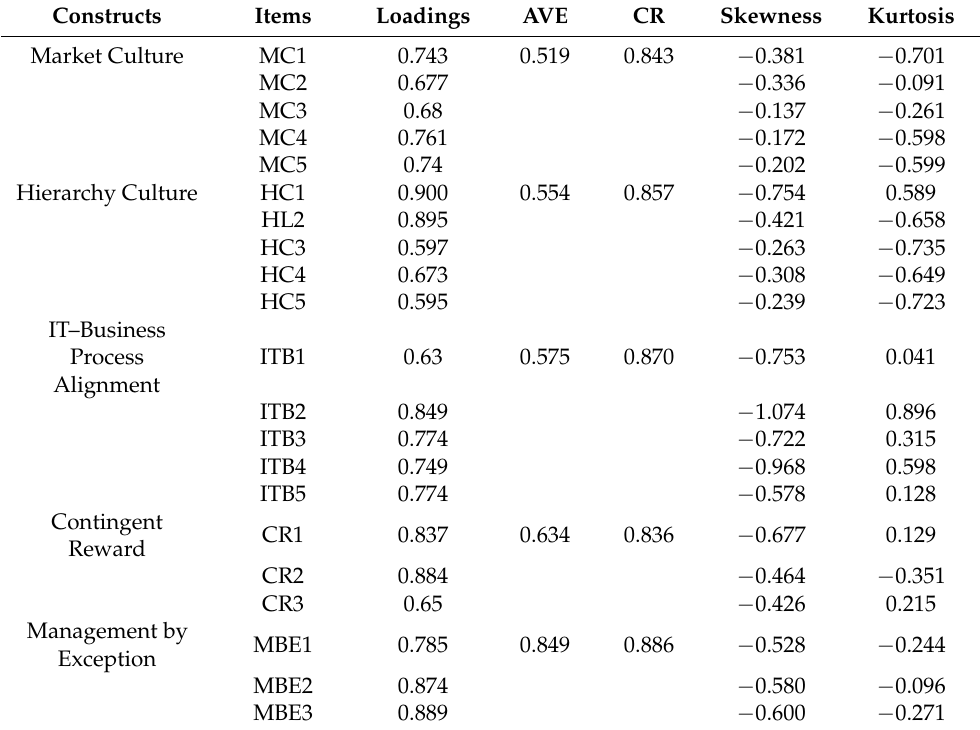
Table 1. Construct validity, reliability, and normality.